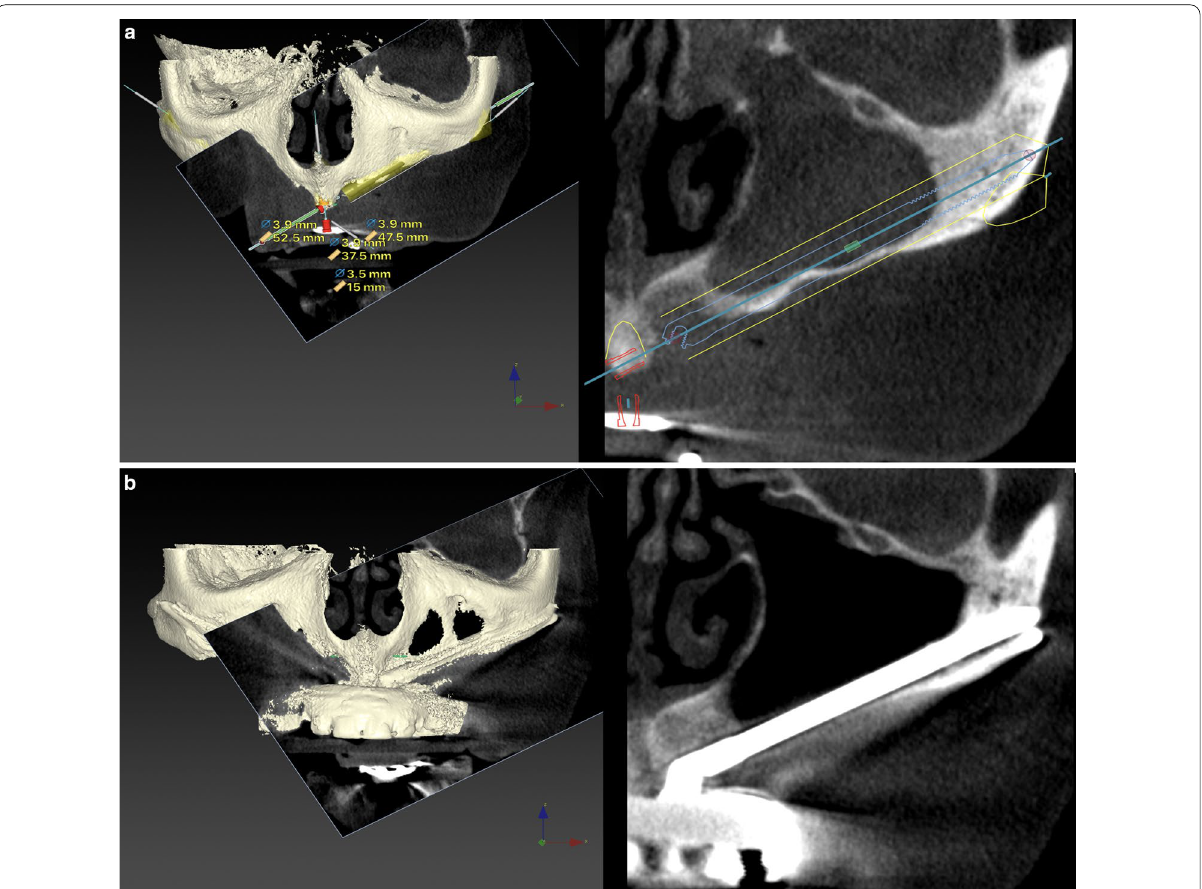
Fig. 10 a Oblique pre‑surgical CBCT cut of patient 6 illustrating the anterior left zygomatic implant planned trajectory. Note the bony defect under the nose caused by the previous loss of a regular implant. Note also that the maxillary sinus is totally occupied and the osteo‑meatal patency is compromised. b One year postoperative oblique CBCT cut of patient 6 illustrating a total regression of the sinus occupation and recovered ostium patency